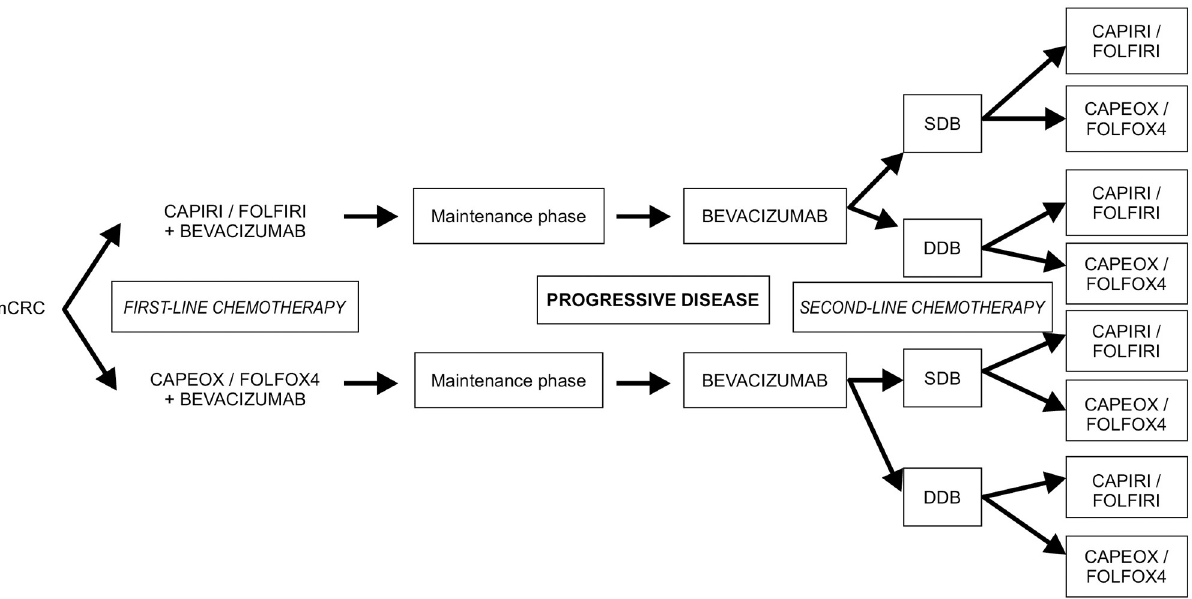
Fig 1. Treatment strategies for the metastatic colorectal cancer patients included in this study. DDB, double-dose bevacizumab; mCRC, metastatic colorectal cancer; SDB, standard-dose Bevacizumab.